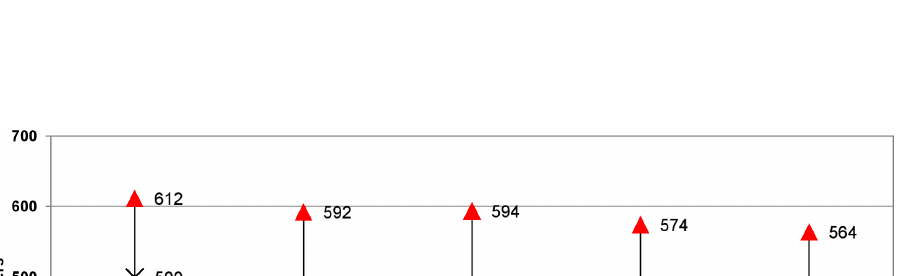
Fig 2. Equity gap in the alcohol-related death rates between those in routine/manual and professional/ managerial occupations: total drinker population. This figure shows the effect of alcohol pricing policies on the gap between alcohol-related death rates for drinkers in the highest and lowest socioeconomic occupation groups. All policies reduce this gap, but volumetric tax and minimum unit pricing ( “ Minimum Price ” ) have larger effects on the gap than ad valorem tax ( “ Sales Tax ” ) or increasing the UK ’ s current tax ( “ Current Tax ” ).